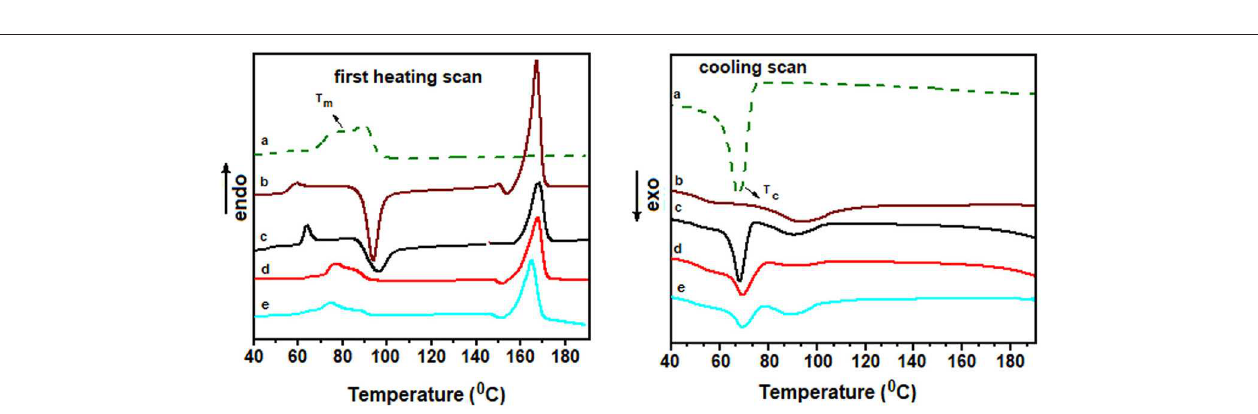
FIGURE 6 | First heating scan and cooling scan curves obtained from DSC thermograms of (a) EVA; (b) PLA; and the PLA/EVA (60:40 wt%) blends loaded with CNT/IL.SO